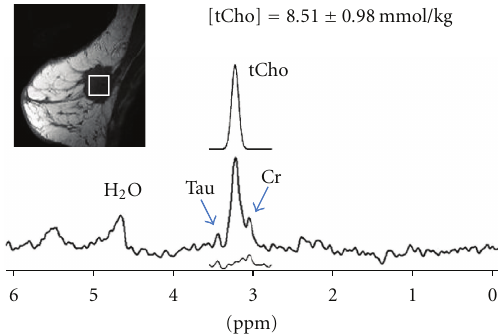
Figure 2: MRI and MRS measurement in a patient with mixed inva- sive ductal and lobular carcinoma. The equivalent 1-dimensional tumor size was 2.8 cm, and the spectroscopic voxel (size 2 × 2 × 2cm 3 ) was superimposed on the hypointense lesion in the pre- contrast sagittal image. The elevated tCho peak at 3.2 ppm is clearly visible in the water-fat suppressed spectrum. The Gaussian model fitting of the tCho peak produces a measurement of [tCho] = 8.51 ± 0.98 mmol/kg, the estimated model fit is shown above the full spec- trum, and the residue is shown underneath. Creatine (Cr) peak at 3.02 ppm and taurine (Tau) peak at 3.45 ppm are also observed. tCho peak in the enhanced areas. The Gaussian model fitting of the tCho peak yields a measurement of [tCho] = 0.66 ± 0.10 mmol/kg, and the residue is shown